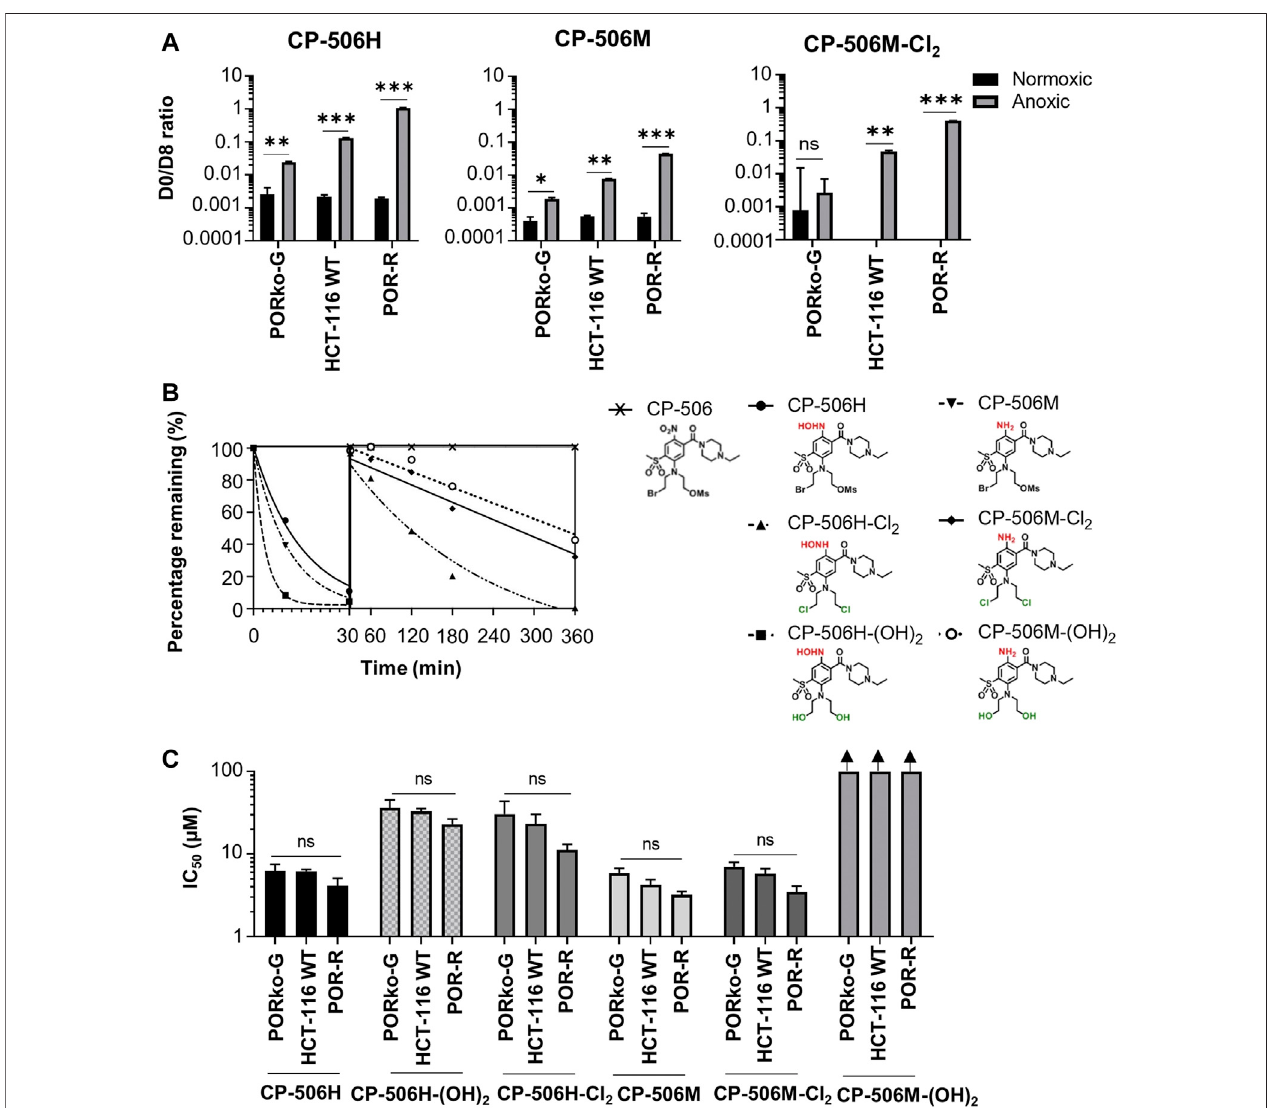
FIGURE 3 | Hypoxia-dependent metabolism of CP-506 leads to the formation of a multitude of short-lived species with variable cytotoxicity. (A) Bioreductive metabolism of CP-506 under normoxic (21% O 2 ) and anoxic conditions ( < 1 ppm O 2 ). Concentrations of CP-506 and its metabolites (CP-506H, CP-506M and CP-506M-Cl 2 ) were quanti fi ed by mass spectrometry with reference to the appropriate deuterated (D8) internal standard. Values are the mean ± SEM for three independent experiments. (B) Stability of CP-506 metabolites in culture medium (without cells) at 37 ° C. Concentrations were determined by mass spectrometry using standard curves generatedfrom authenticated stocks. (C) Anti-proliferative potency after exposure ofmonolayer cultures to CP-506 metabolites for 5 days under normoxic conditions (21% O 2 ). IC 50 values are the mean ± SEM of duplicate wells for three independent experiments. T-tests were performed using GraphPad Prism 8 (ns, p-value > 0.05; *, p -value ≤ 0.05; **, p -value ≤ 0.01; ***, p -value ≤ 0.001).